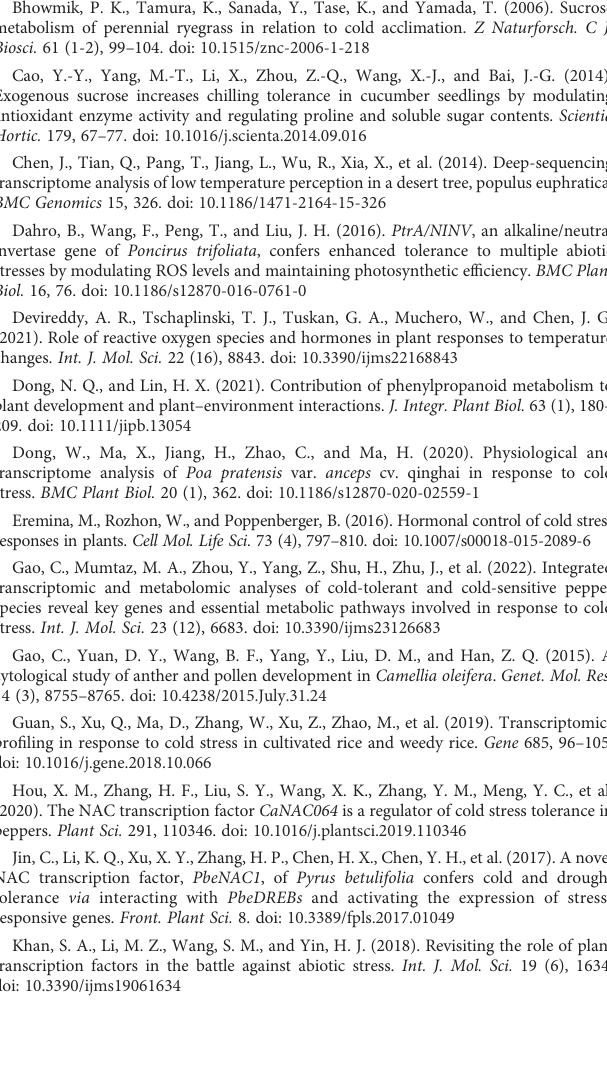
DEGs detected in HS and HX at different times of cold